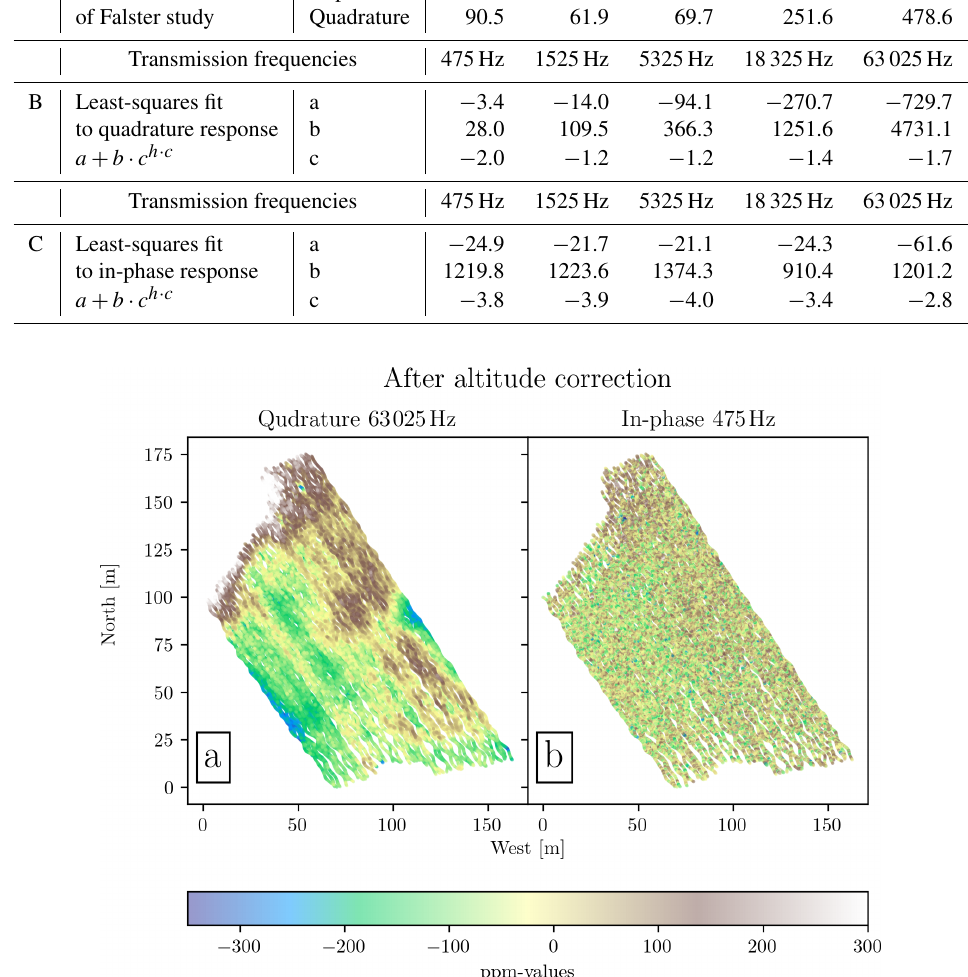
Figure 12. Falster survey data before and after altitude correction. (a) Quadrature response at 63025Hz, (b) altitude-corrected quadrature response at 63025Hz, (c) in-phase response at 475Hz, (d) altitude-corrected in-phase response at